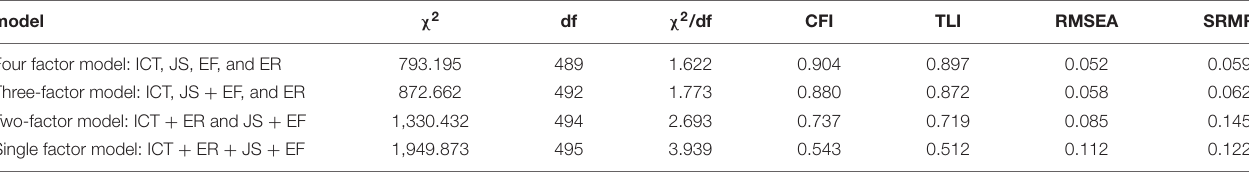
TABLE 2 | Comparison of the goodness-of-fit indices of alternative models. model χ 2 df χ 2 /df CFI TLI RMSEA SRMR